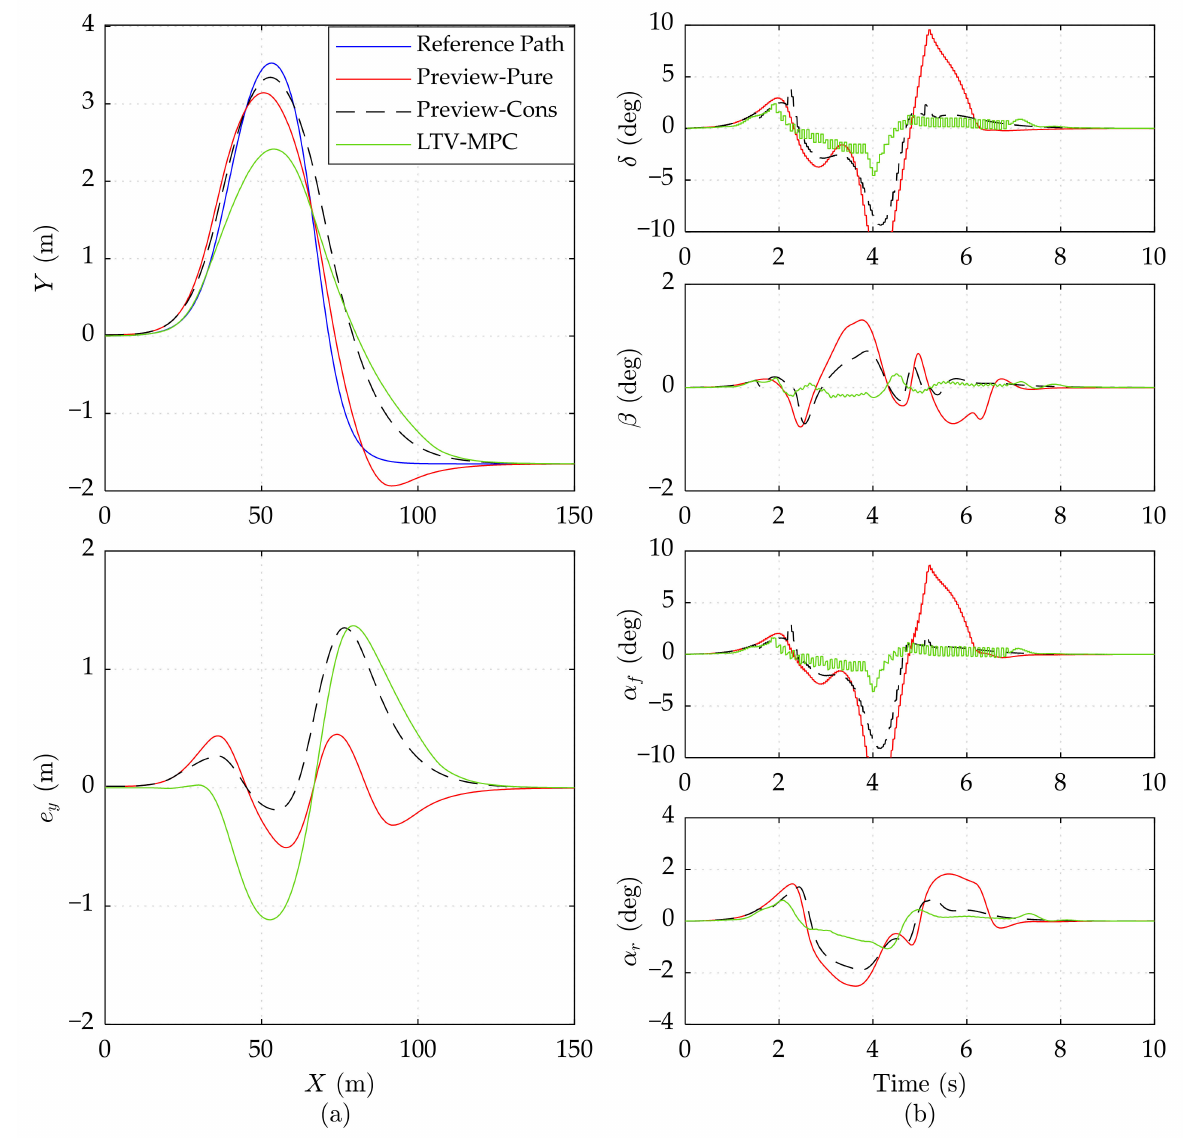
Figure 7. Simulation results of three controllers on the low adhesion road at 15 m/s speed. ( a ) Vehicle driving trajectory, lateral error e y . ( b ) Front wheel steering angle δ , mass center slip angle β , front wheel slip angle α f , and rear wheel slip angle α r . The results of Preview-Pure beyond range are cut